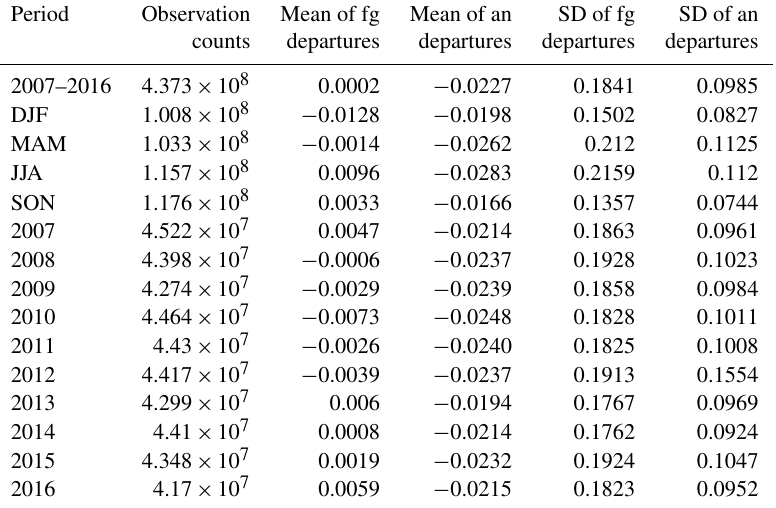
Table 5. Statistics (mean and SD) of departures of DOD coarse first guess (fg) and analysis (an) from assimilated observations calculated for the full period (2007–2016), for different seasons (DJF, MAM, JJA, SON) and for individual years. The number of observation counts is also